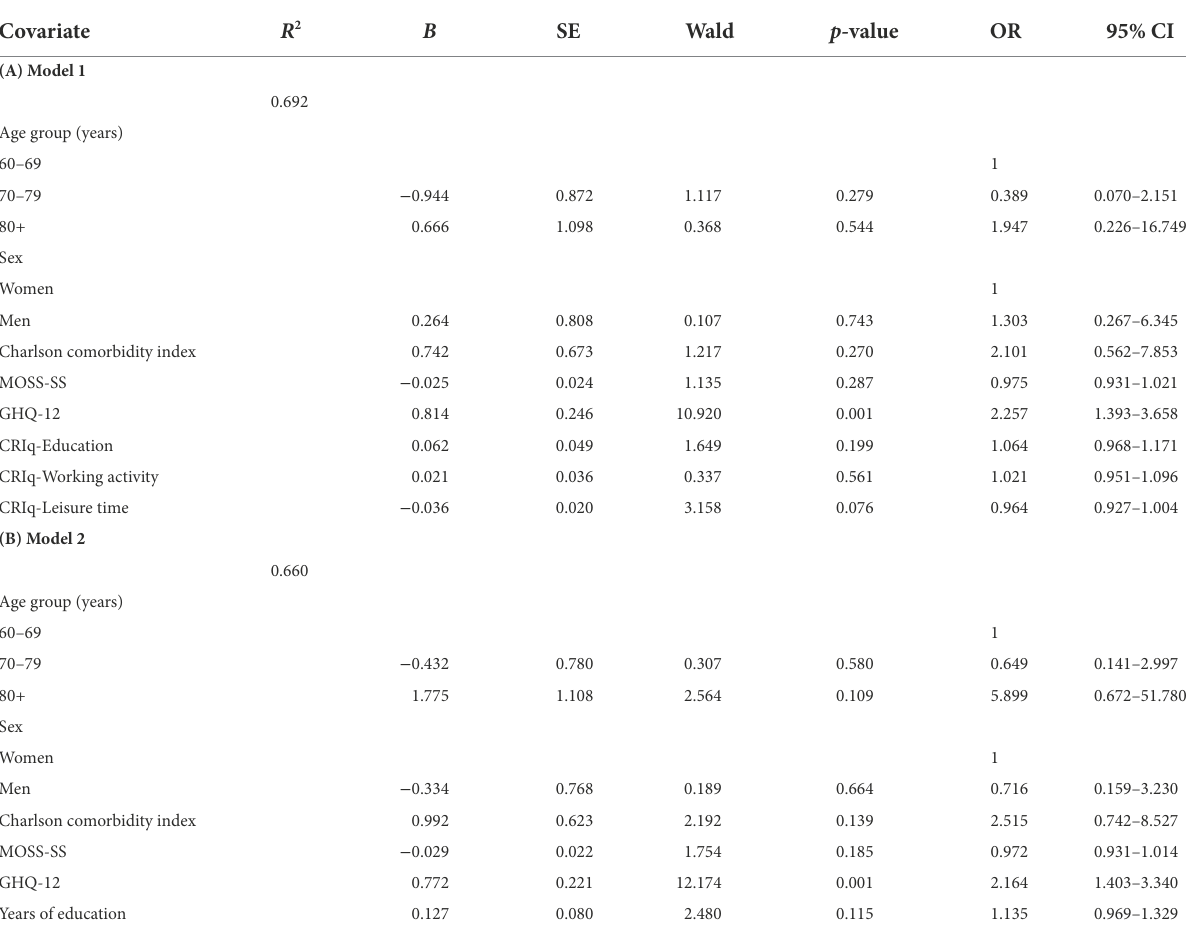
TABLE 3 Multivariate regression